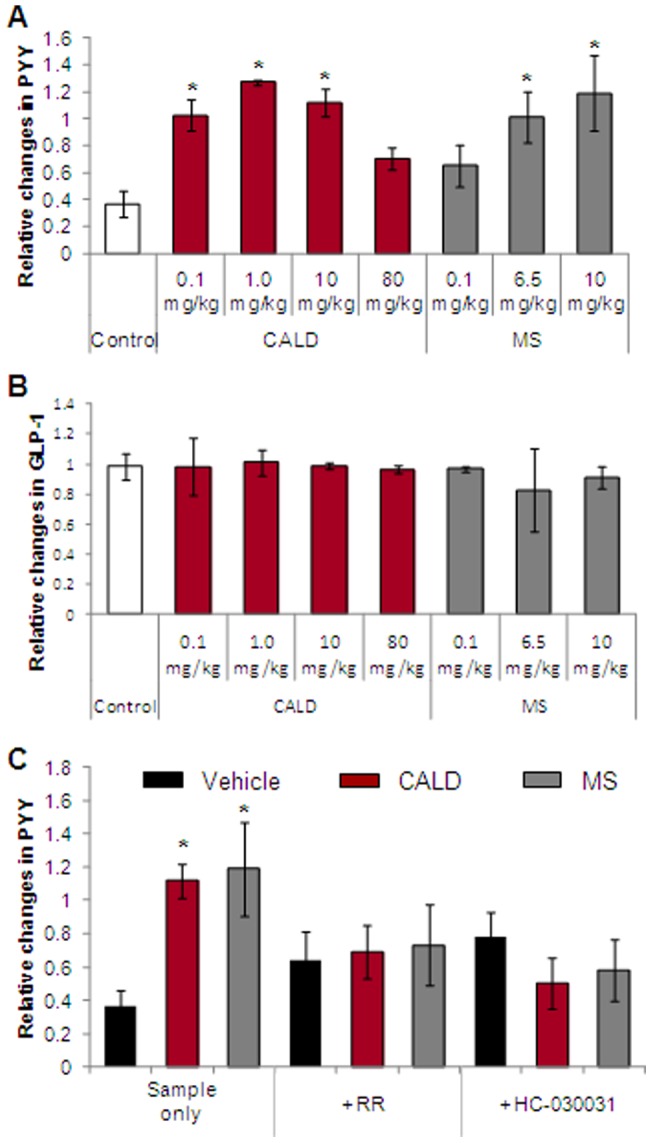
Effects of cinnamaldehyde (CALD) or methyl syringate (MS) on plasma PYY and glucagon-like peptide (GLP-1) levels.Vehicle (1.5% methyl cellulose), CALD, or MS were administered orally to ICR mice at a dose of 10 mg/kg after fasting in the presence or absence of the TRPA1 antagonists RR and HC-030031. Plasma PYY (A) or GLP-1 levels (B) upon CALD and MS treatment alone or with the addition of RR and HC-030031 (C) were evaluated at 0 min and 15 min and relative values calculated. Columns and vertical bars represent means ± SEM (n = 4); *p<0.05 compared with the vehicle control.